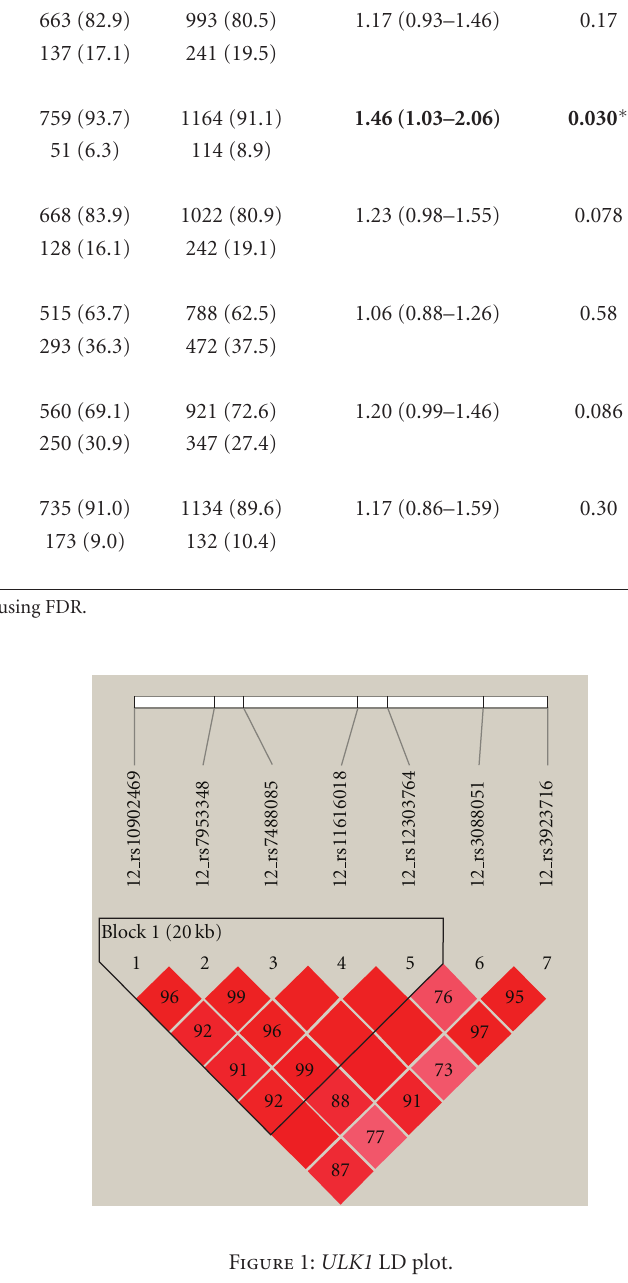
Figure 1: ULK1 LD